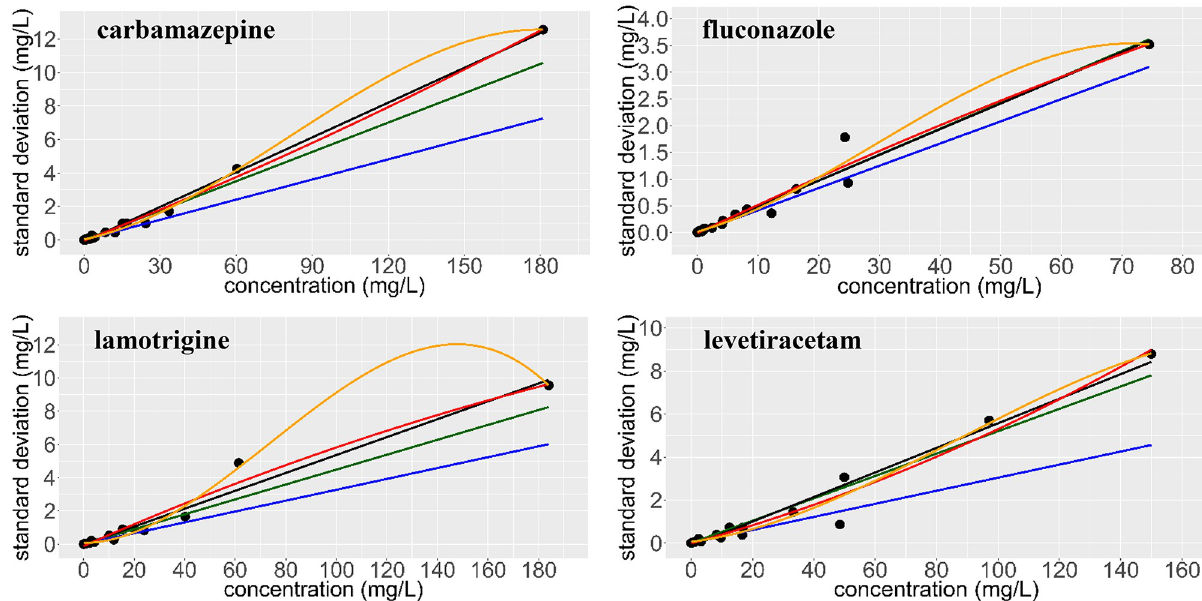
Fig 4. Regression plots obtained by applying various regression algorithms to the precision profiles of carbamazepine, fluconazole, lamotrigine and levetiracetam and by using all of the serum specimens (N = 24) and spiking levels (M = 20+blank) of the 3 experiments. Each data point displays the standard deviation of the assay results. Green line: Theil’s regression, black line: unweighted linear least squares, blue line: 1/x 2 -weighted linear least squares, red curve: unweighted 2 nd -order least squares, orange curve: unweighted 3 rd -order least squares regression. See Table 5 for a detailed